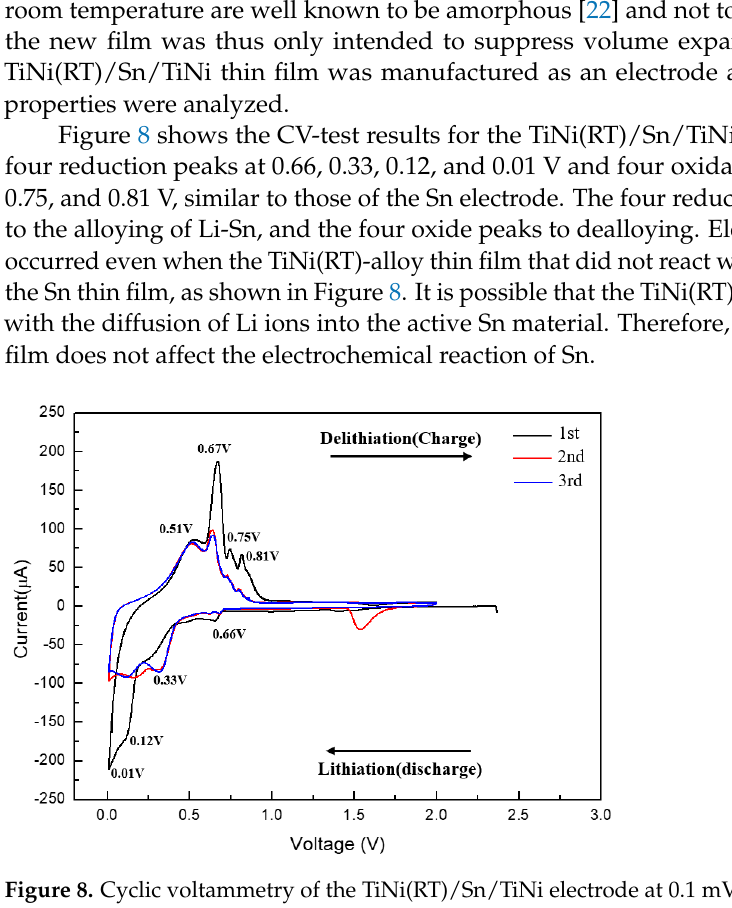
Figure 7. Cycle performance of the Sn and Sn/TiNi electrodes at 0.5 C.